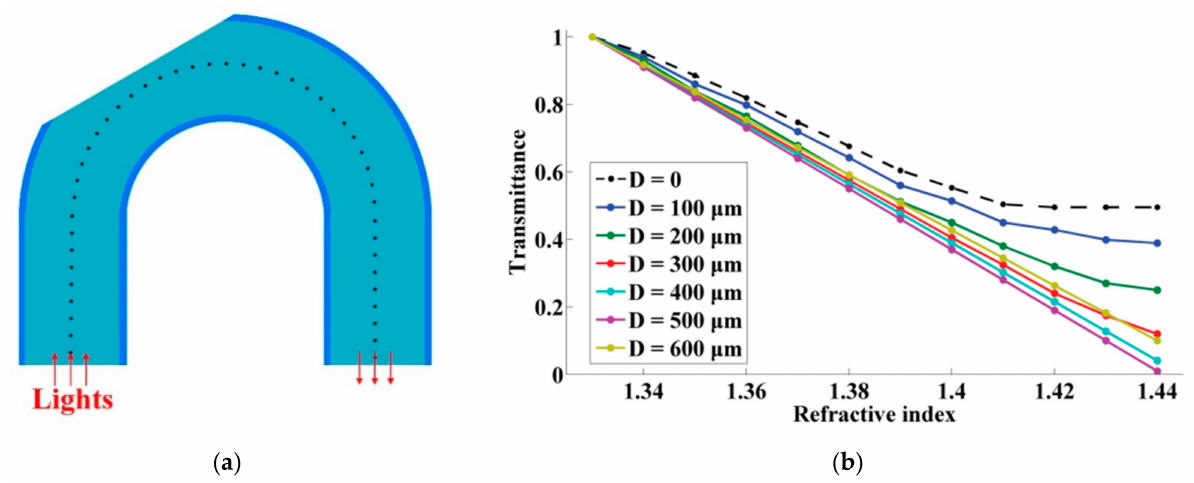
Figure 9. The schematic diagram of the side-polished macro-bending POF ( a ), and the effect of polished depth on the RI sensing performance ( b ) [90].